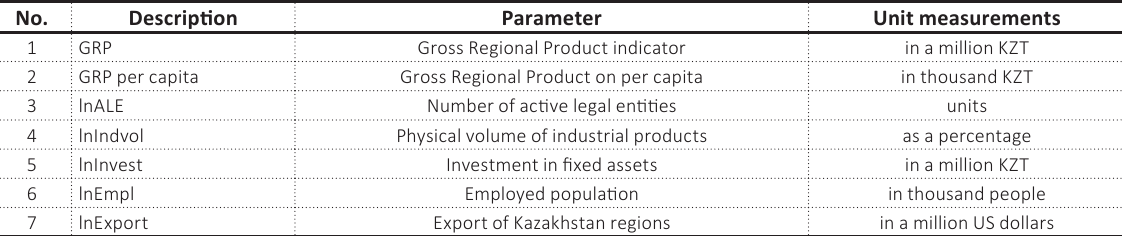
Table 1. Description of the selected